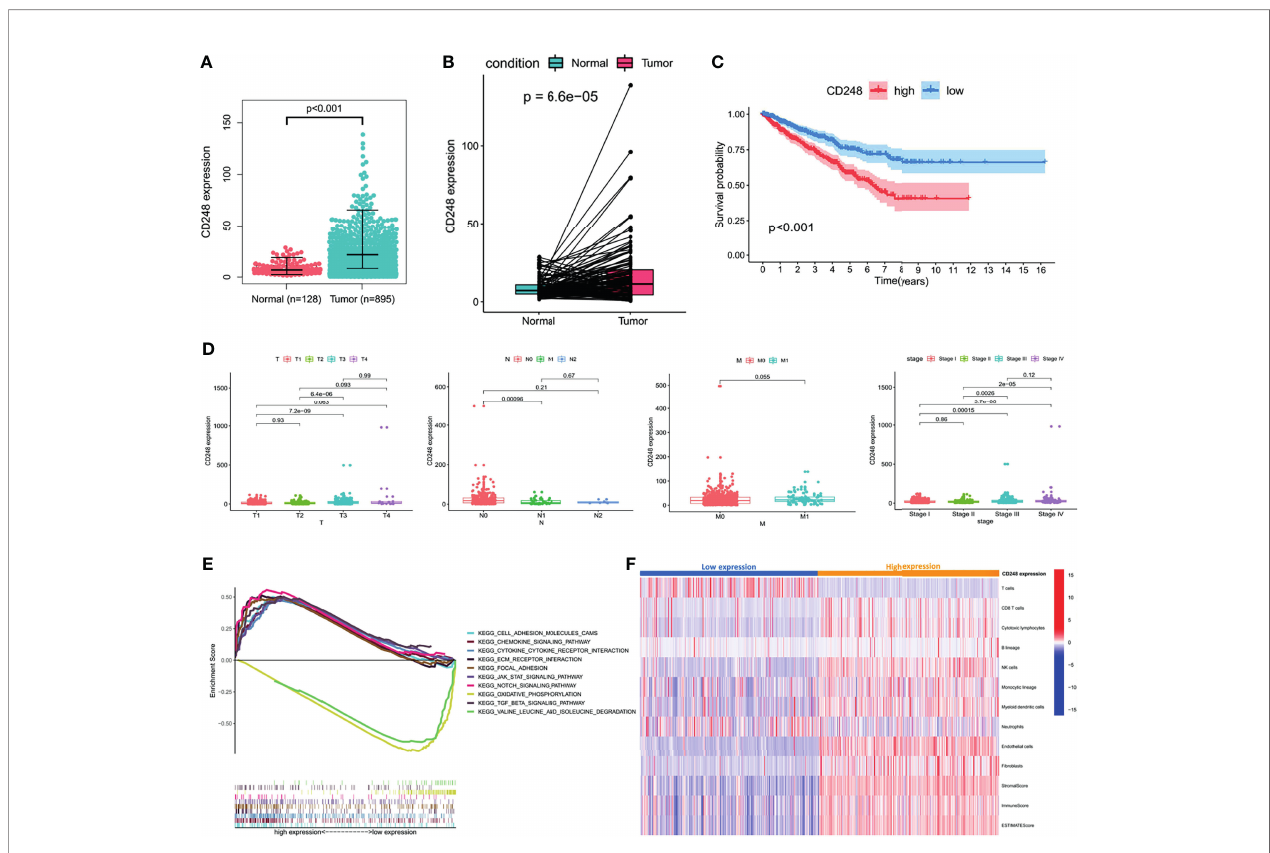
FIGURE 1 | The role of CD248 in RCC progression. (A, B) CD248 overexpression in RCC. (C) Kaplan – Meier analysis of the OS in high and low CD248-expressing patients with RCC in the TCGA cohort. (D) Clinicopathological correlation of CD248 in RCC. (E) GSEA of KEGG pathways analysis. (F) Heatmap of TME cells was shown after grouping by CD248. p < 0.05 was considered statistically signi fi